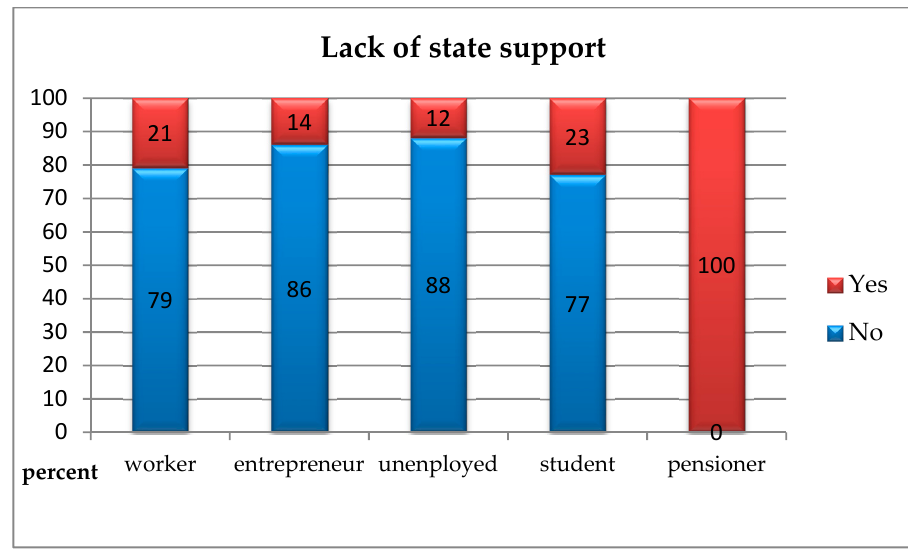
Figure 5. The absence of the full range of products which consumers would like to see on store shelves as a current problem with the market for environmental goods according to people with a different social status. Int. J. Environ. Res. Public Health 2019 , 16 , x FOR PEER REVIEW